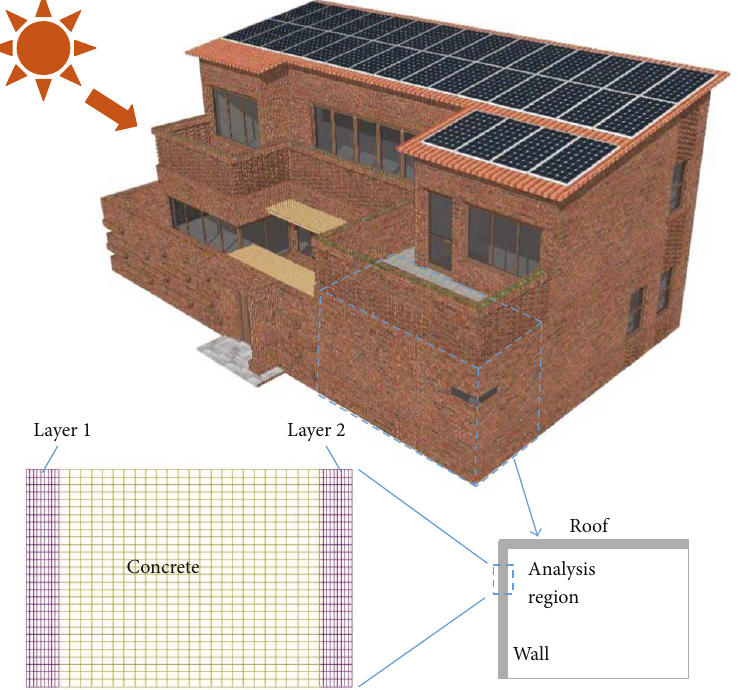
Figure 1: Schematics of the resident house and enlargement of the analysis region with structure